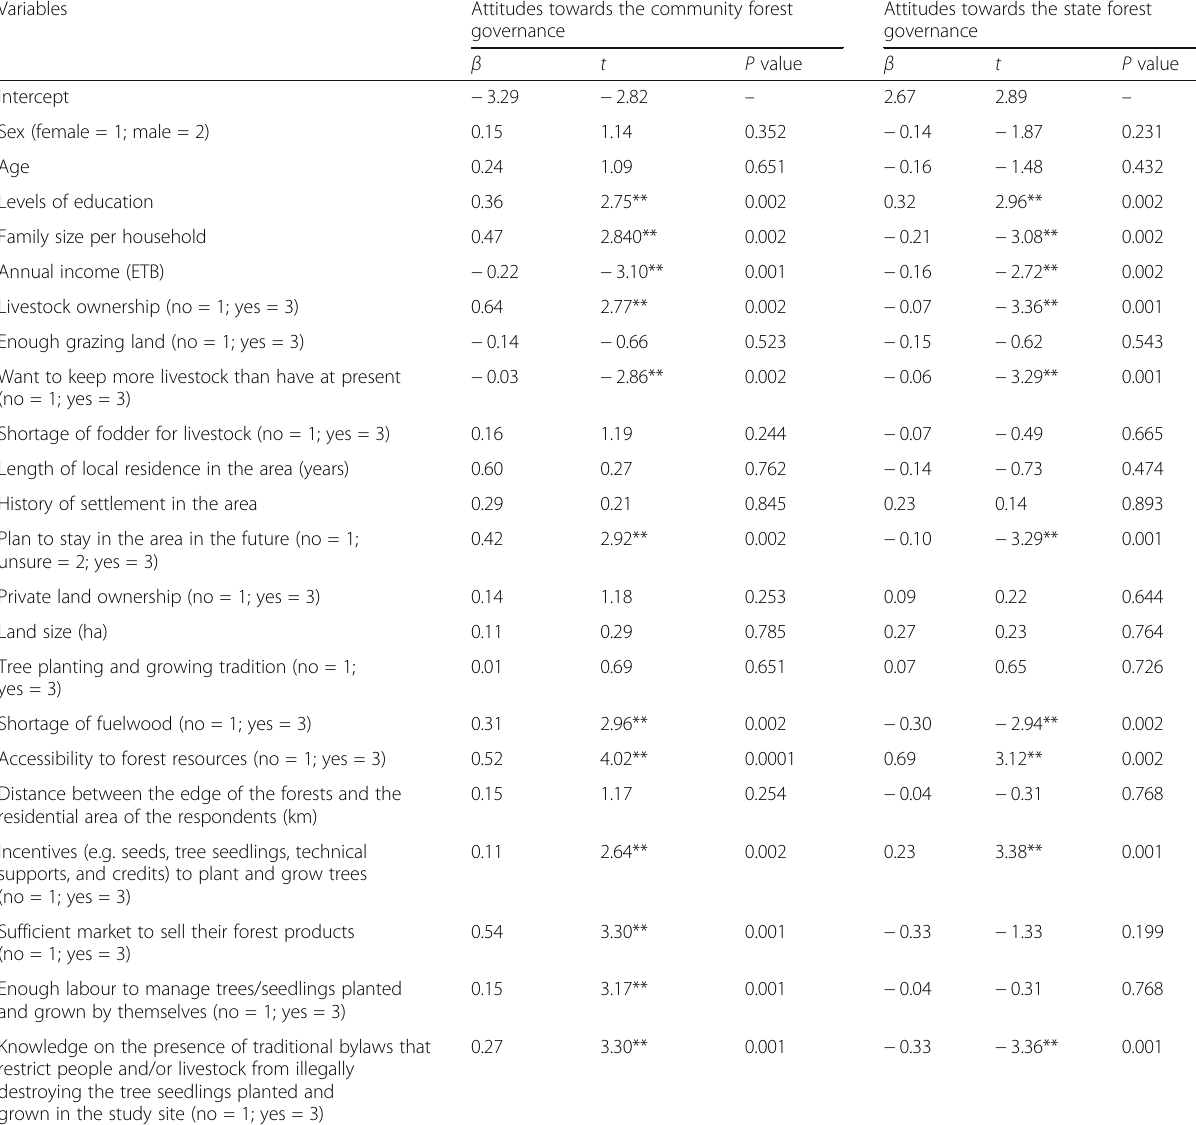
Table 3 Multiple linear regression model to predict the attitudes of local people towards the community forest governance, and the state forest governance in Tehulederi District Variables Attitudes towards the community forest Attitudes towards the state forest governance